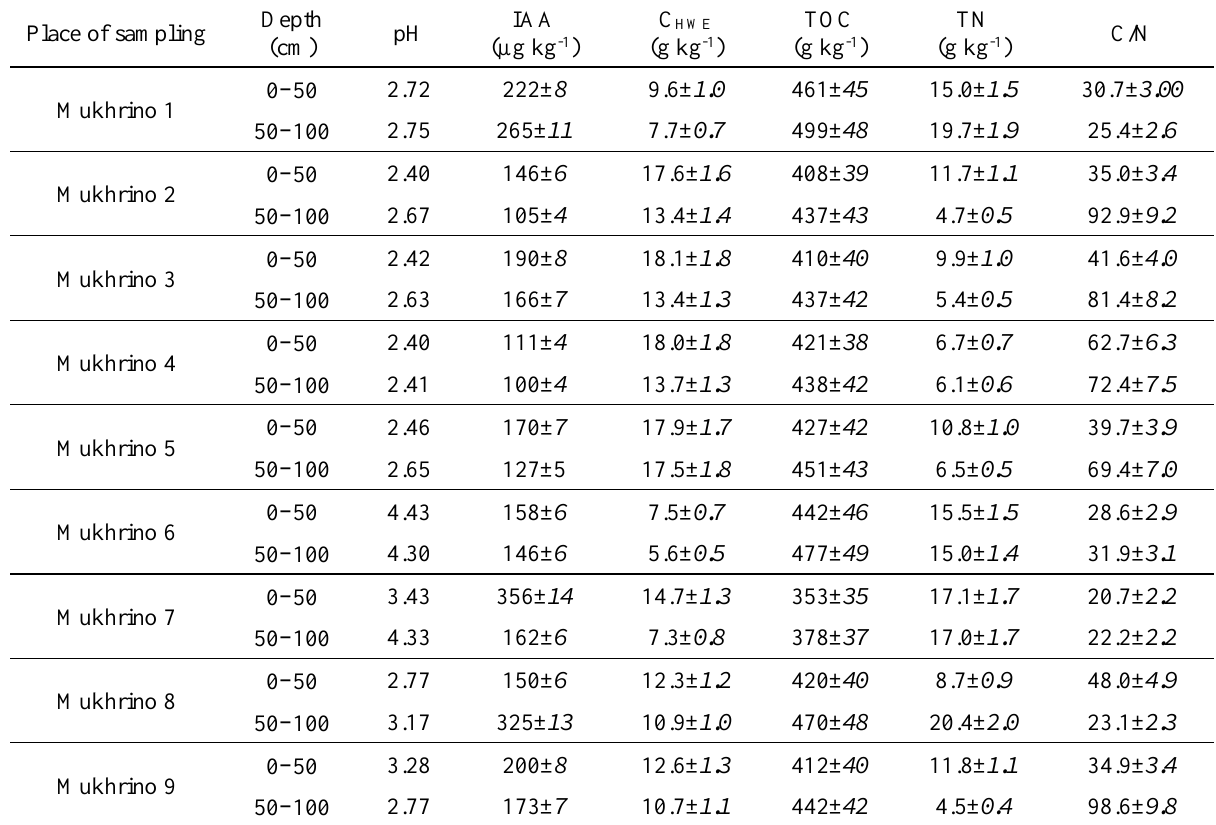
Table 4. Mean contents of chemical compounds and physical factors in the investigated soils (Russian site). Explanation of column headings as for Table 3.